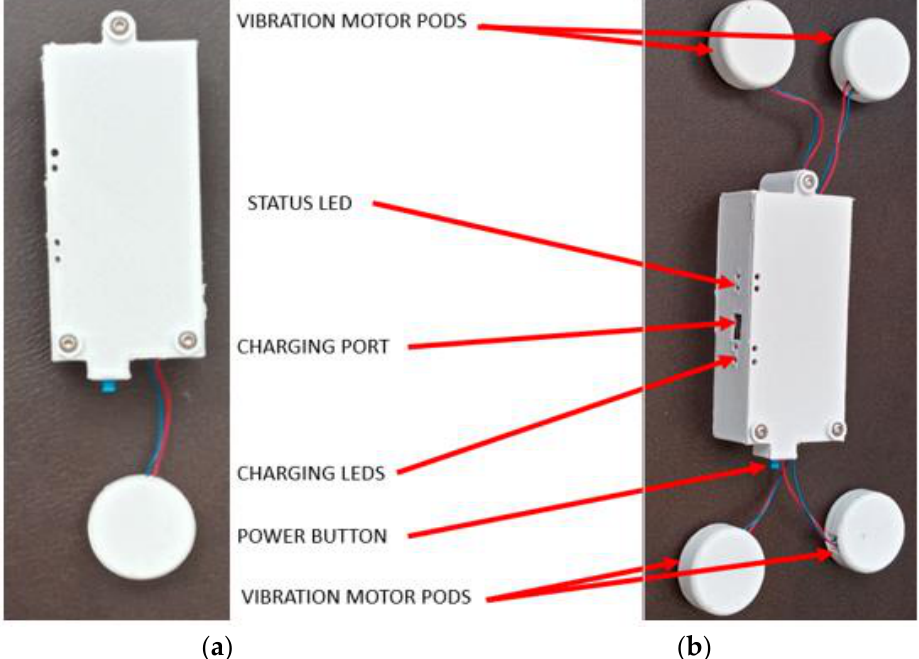
Figure 1. Prototype of FoVi. (( a ) — left) The first prototype with one pod attached to the main controller and (( b ) — right) the final design with four pods attaches to the main controller.